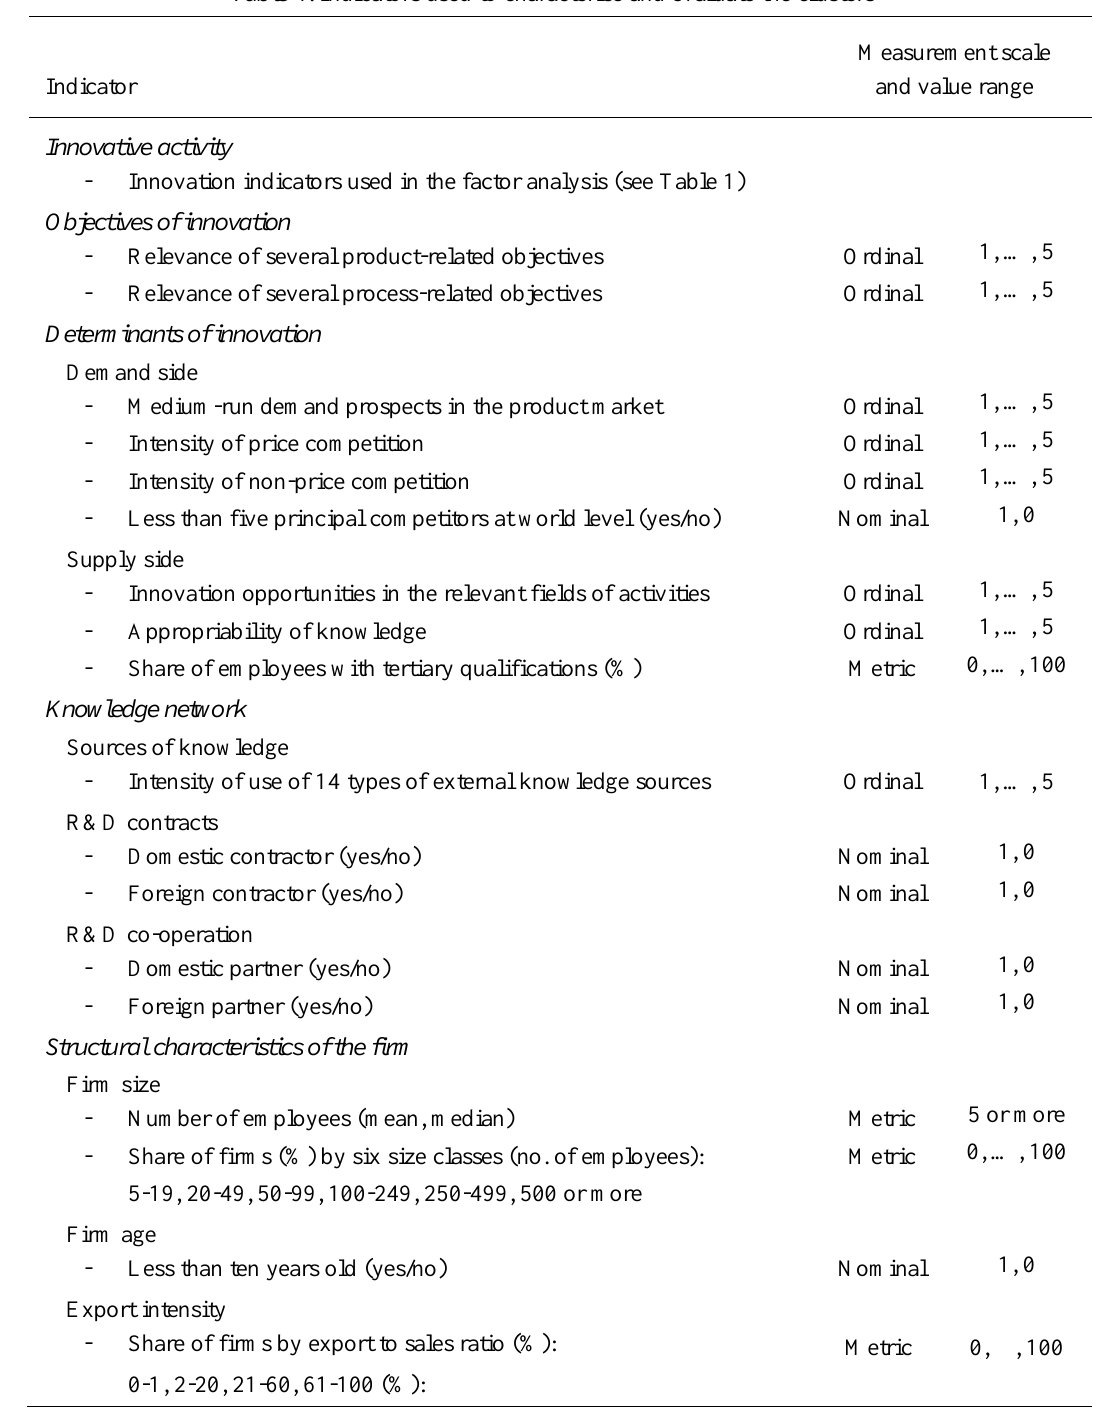
Table 4 : Indicators used to characterise and evaluate the clusters